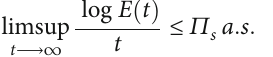
ð α Þ = 0 : 01 , and 4